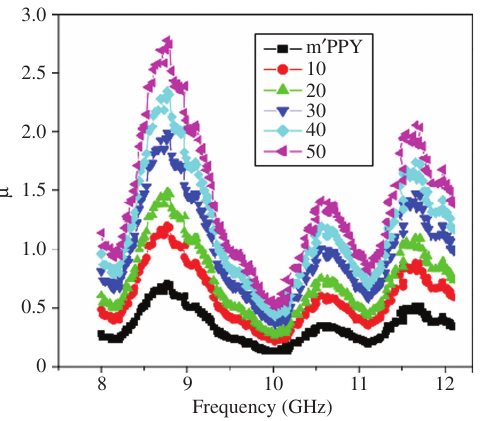
Figure 4 Real part of permeability as a function of applied frequency.